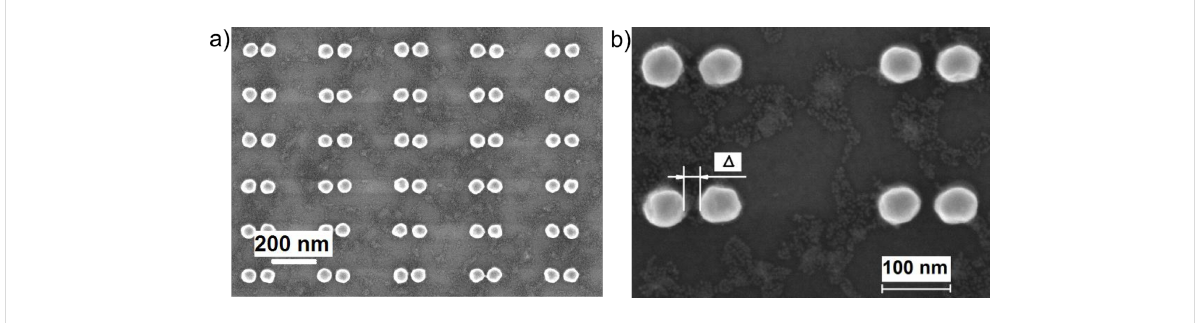
Figure 4: (a) SEM image of submonolayer coverage of CdSe NCs deposited on a Au dimer array. (b) An enlarged fragment of the SEM image of the structure shown in (a). The dimer gap is denoted as Δ .